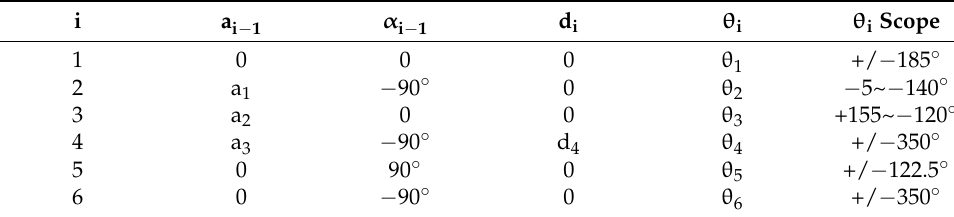
Table 1. Basic parameters of grinding